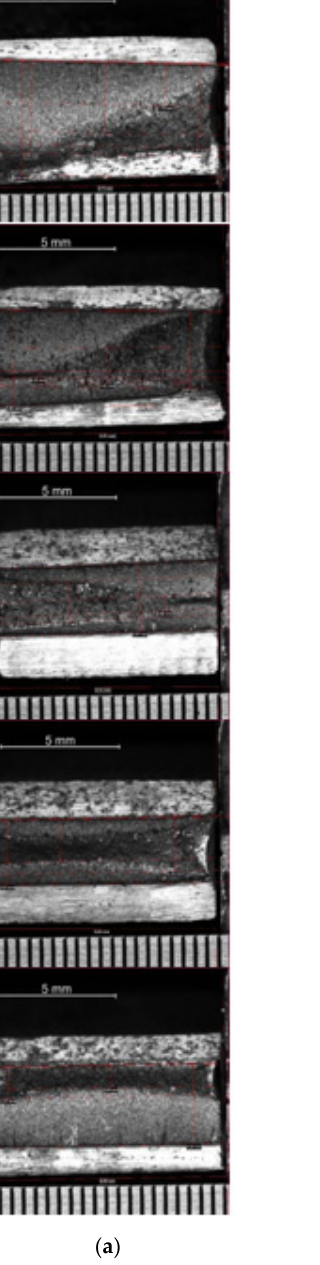
Figure 15. Sample fractography. ( a ) Bembézar Stringers; ( b ) Bembézar Main Chords. Table 7. Results (Bembézar): Avg. growth per cycle, cycles per mm of crack growth.